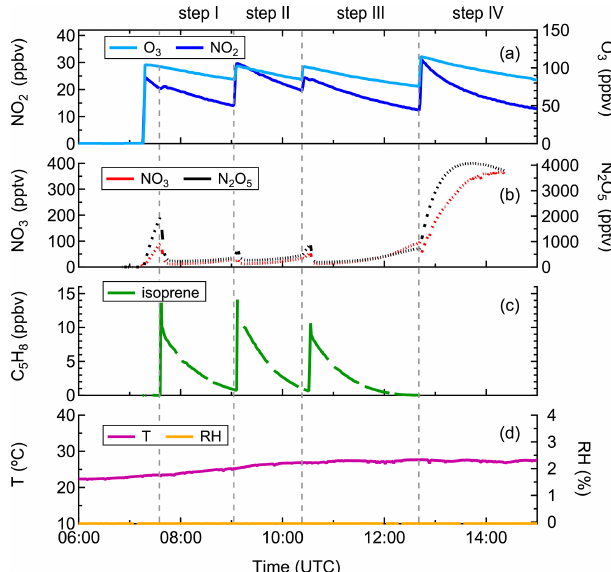
Figure 1. Measurements of (a) O 3 and NO 2 , (b) NO 3 and N 2 O 5 , (c) isoprene, and (d) temperature and relative humidity in the chamber during the experiment on 8 August